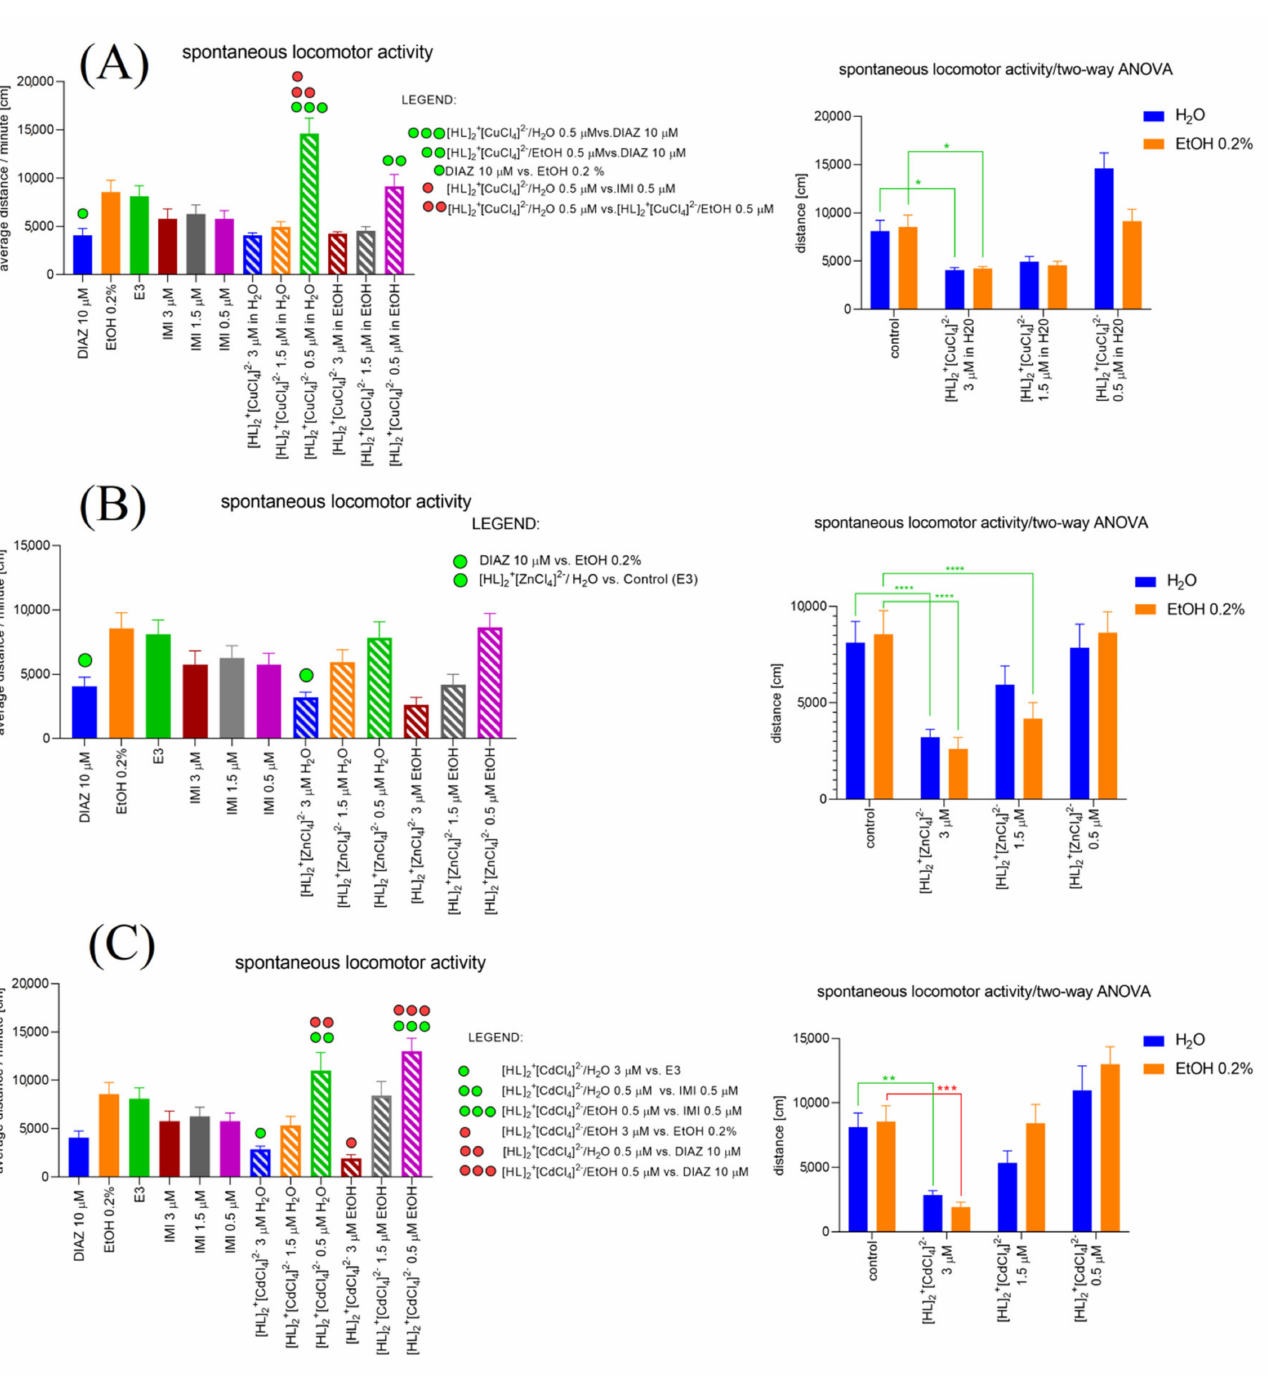
Figure 11. [HL] 2 + [CuCl 4 ] 2 ( A ), [HL] 2 + [ZnCl 4 ] 2 − ( B ), and [HL] 2 + [CdCl 4 ] 2 − ( C ) influence on the Zebrafish larvae’s spon- taneous locomotor activity compared with the changes caused by imipramine and diazepam ( left ). Evaluation of the solvent-dependent manner of changes in the spontaneous locomotor activity of Zebrafish larvae under the influence of [HL] 2 + [CuCl 4 ] 2 ( A ), [HL] 2 + [ZnCl 4 ] 2 − ( B ), and [HL] 2 + [CdCl 4 ] 2 − ( C ) ( right